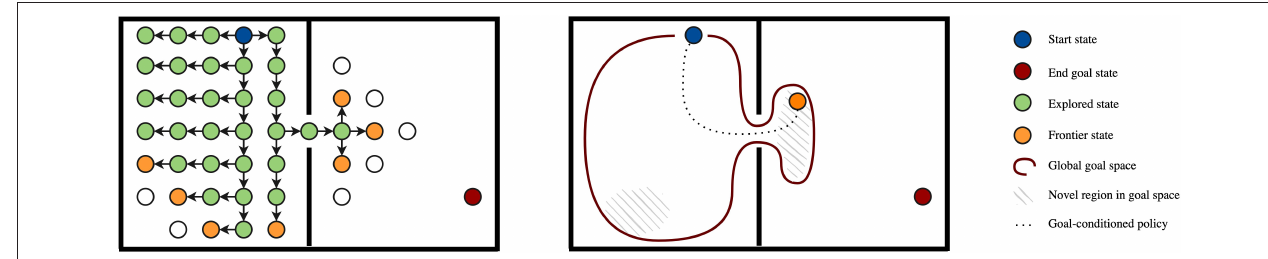
FIGURE 5 | Frontier-based exploration in planning (left) and reinforcement learning (right, intrinsic motivation ). Left: Frontier and explored set in a graph. Blue denotes the start state, red a final state, green denotes the explored set (states that have been visited and whose successors have been visited), orange denotes the frontier (states that have been visited but whose successors have not all been visited). Methods without a frontier and explored set (like random perturbation, which is used in most RL approaches) may sample many redundant trials that make loops in the left part of the problem, because they do not find the narrow passage. Right: In large problems, it may become infeasible to store the frontier and explored set in tabular form. Part of intrinsic motivation literature (Colas et al., 2020) tracks global (sub)goal spaces (red line) in global, approximate form. We may for example sample new goals from this space based on novelty, and subsequently attempt to reach that goal through a goal-conditioned policy, effectively mimicking frontier-based exploration in approximate, global